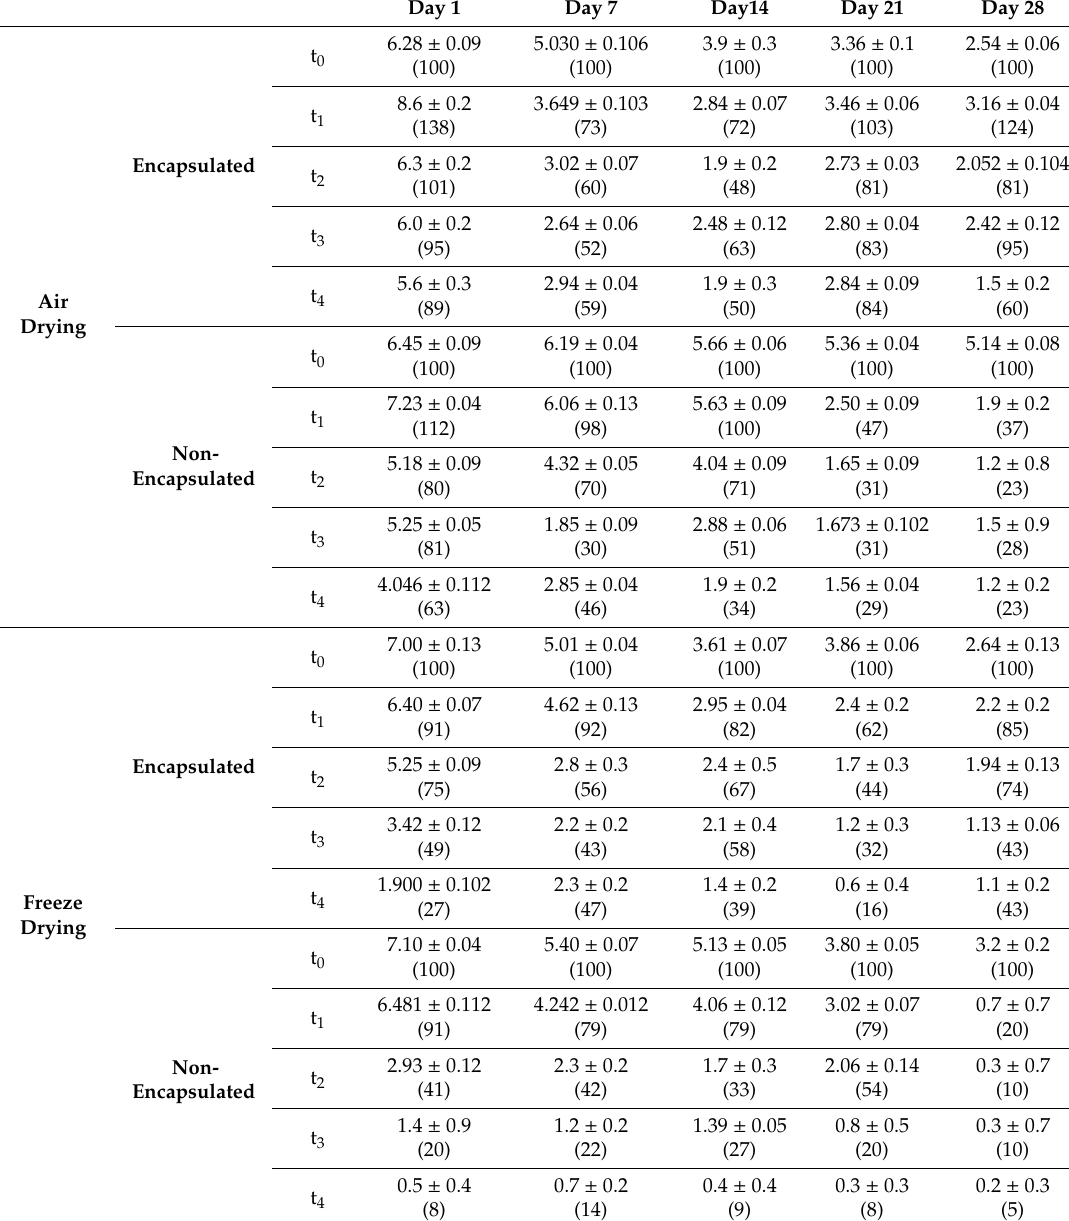
Table 4. Microbial content of L. salivarius spp. salivarius encapsulated and non-encapsulated (Log CFU / g dried ) during the digestion process of dried apples stored for 28 days of storage. The number in brackets indicates the survival of microorganisms in percentage. Results expressed as mean ± standard deviation of four